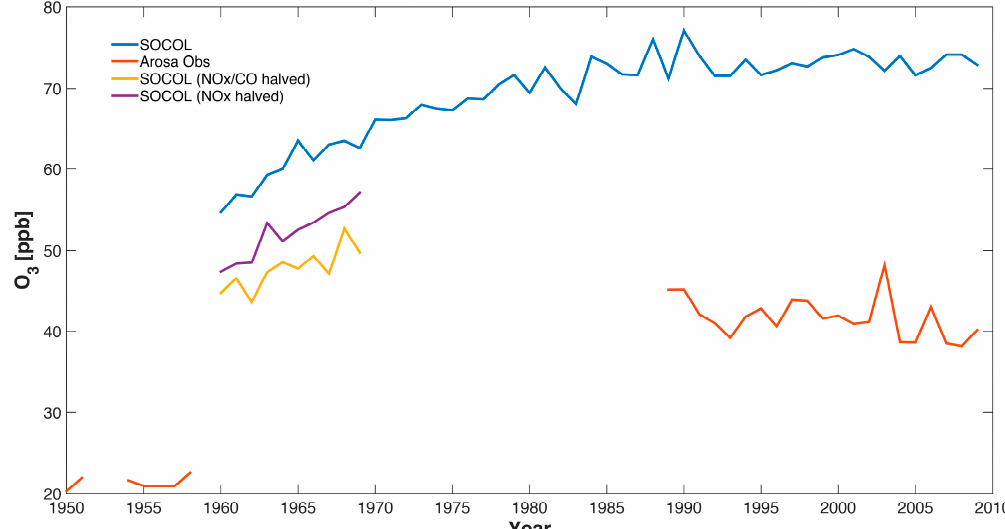
Figure 5. Comparison of ozone measurements and the SOCOLv3 historical (REF-C1) simulation (annual mean values) at Arosa, Switzerland. The SOCOL data are extracted from the 850 hPa level. Note that the values for the years 1954–1958 are a multi-year mean and are thus the same for all years. Atmosphere 2017 , 8 , 163